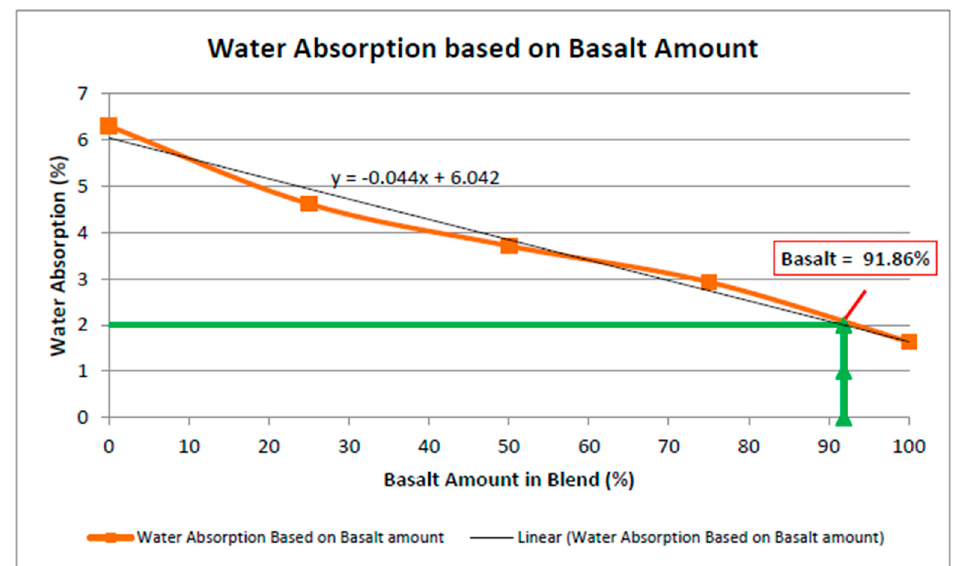
Figure 16. Regression Analysis for Determination of Optimum Basalt Amount.